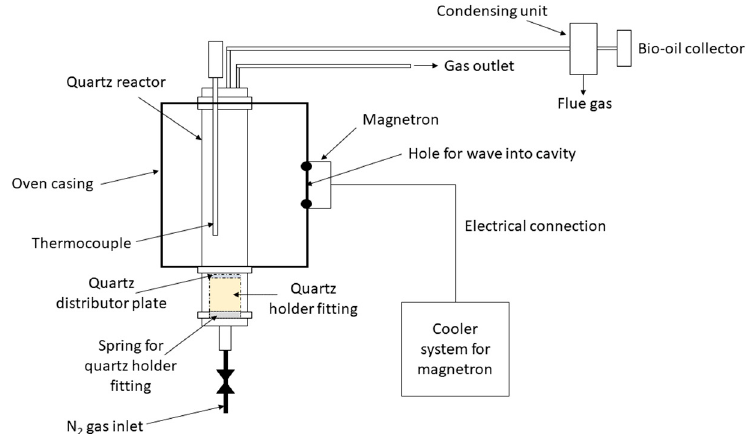
Figure 5. Schematic of microwave reactor as used by Mokhtar et al. (Adapted from [60]).